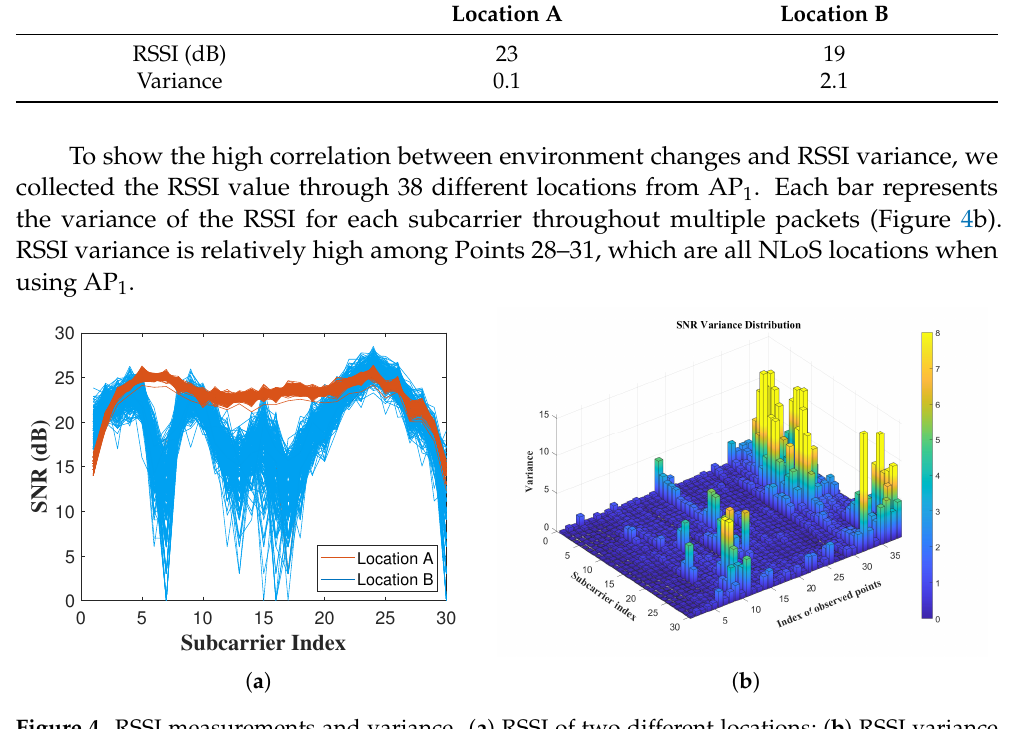
Figure 4. RSSI measurements and variance. ( a ) RSSI of two different locations; ( b ) RSSI variance among all the